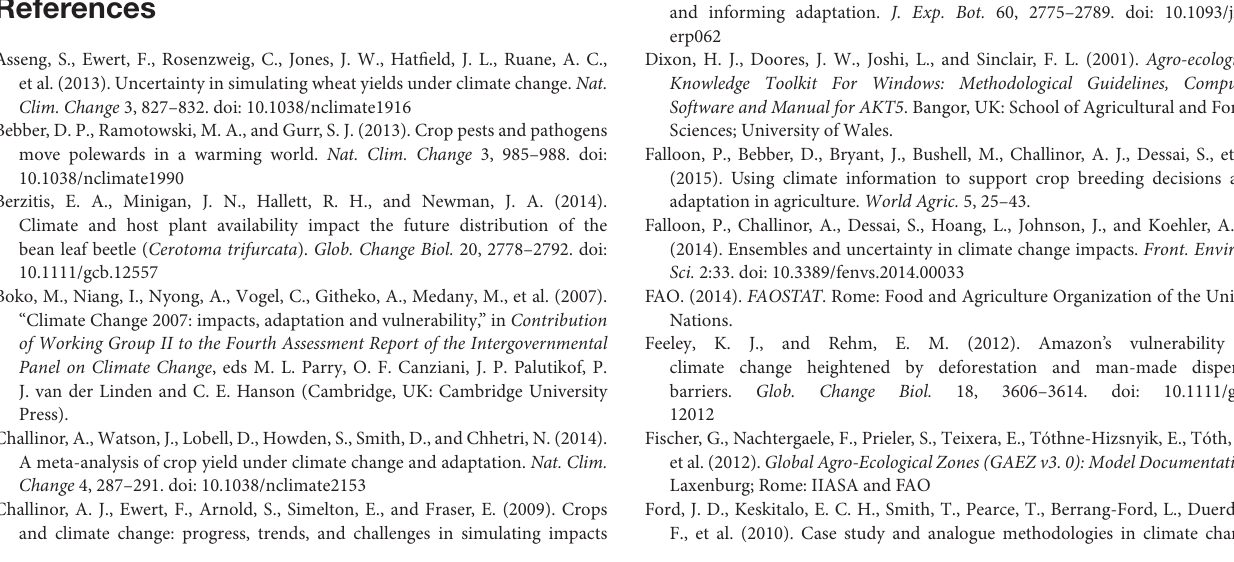
Figure S1 | Distributions of monthly precipitation, mean daily maximum, and minimum temperatures derived from the WorldClim database. Data are shown for the current climate of the baseline location, projected climate at the baseline location, and current climate at analog locations corresponding to projected futures according to three climate models, for the A2a greenhouse gas emissions scenario and the 2020s projection horizon. Figure S2 | Distributions of monthly precipitation, mean daily maximum, and minimum temperatures derived from the WorldClim database. Data are shown for the current climate of the baseline location, projected climate at the baseline location, and current climate at analog locations corresponding to projected futures according to three climate models, for the A2a greenhouse gas emissions scenario and the 2080s projection horizon. Figure S3 | Distributions of monthly precipitation, mean daily maximum, and minimum temperatures derived from the WorldClim database. Data are shown for the current climate of the baseline location, projected climate at the baseline location, and current climate at analog locations corresponding to projected futures according to three climate models, for the B2a greenhouse gas emissions scenario and the 2020s projection horizon. Figure S4 | Distributions of monthly precipitation, mean daily maximum, and minimum temperatures derived from the WorldClim database. Data are shown for the current climate of the baseline location, projected climate at the baseline location, and current climate at analog locations corresponding to projected futures according to three climate models, for the B2a greenhouse gas emissions scenario and the 2050s projection horizon. Figure S5 | Distributions of monthly precipitation, mean daily maximum, and minimum temperatures derived from the WorldClim database. Data are shown for the current climate of the baseline location, projected climate at the baseline location, and current climate at analog locations corresponding to projected futures according to three climate models, for the B2a greenhouse gas emissions scenario and the 2080s projection